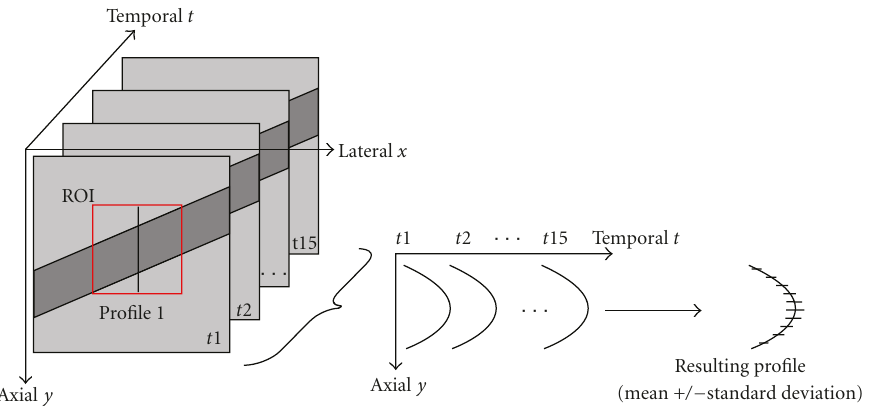
Figure 8: Computation of profiles (mean ± standard deviation) from estimates on 15 successive frames.